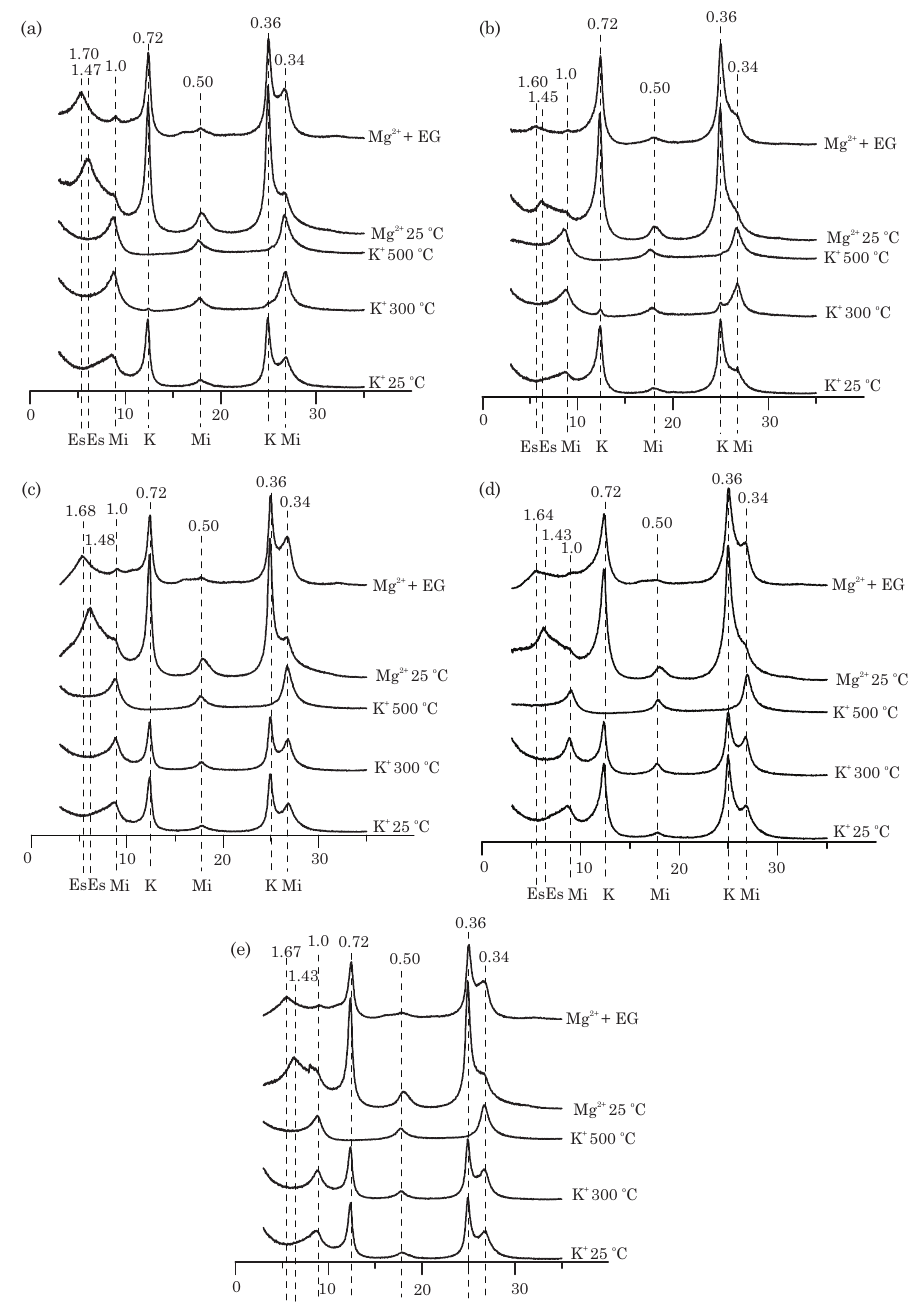
Figure 7. Diffractograms (°2 θθθθθ CuK ααααα ) of fine clay in horizons after (a, c, e) and before (b, d) the avulsion process in AP1: (a) 30-75 cm - post; (b) 145-200 cm - pre); AP4: (c) 30-45 cm - post, (d) 150-190 cm - pre; and AP10: (e) 105-150 cm - post. K=Kaolinite, Mi=Mica,